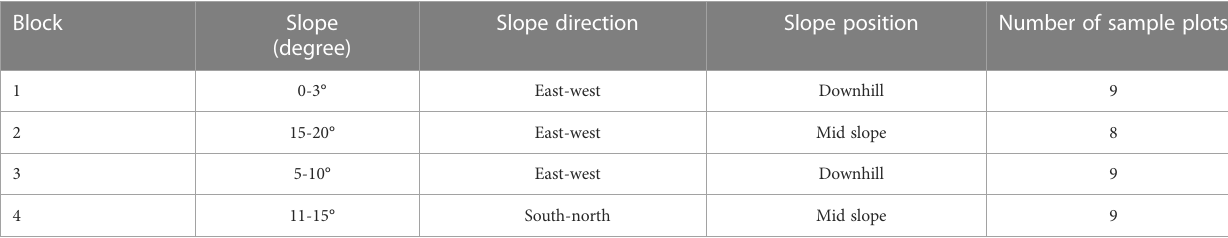
Slope position Number of sample plots